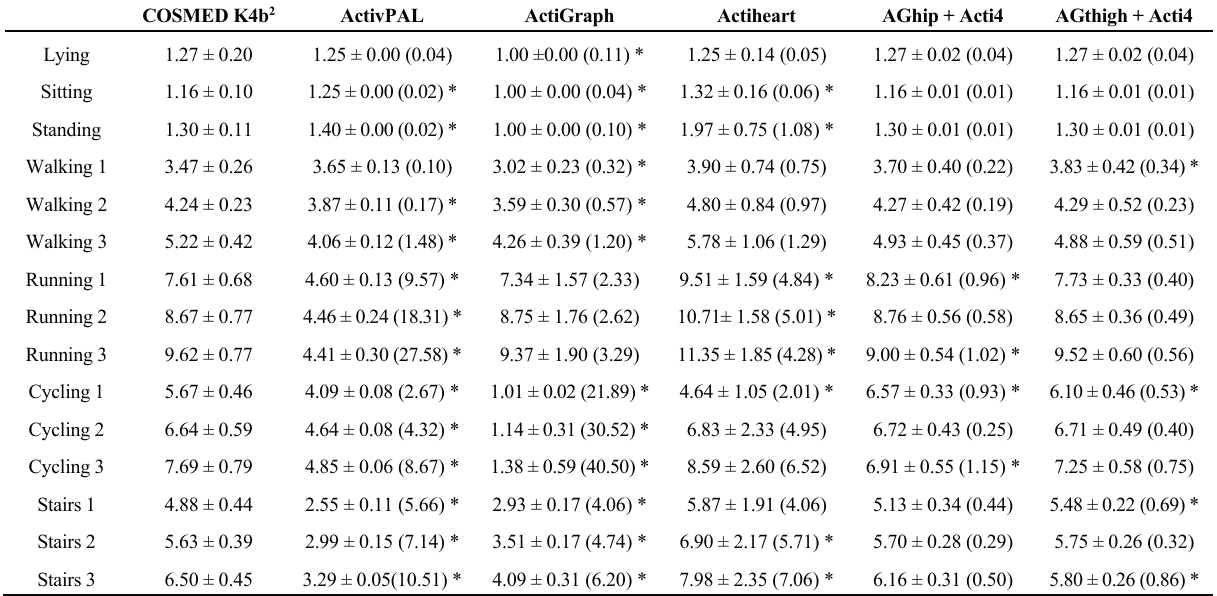
Table 3. Comparisons between measured EE by COSMED K4b 2 (indirect